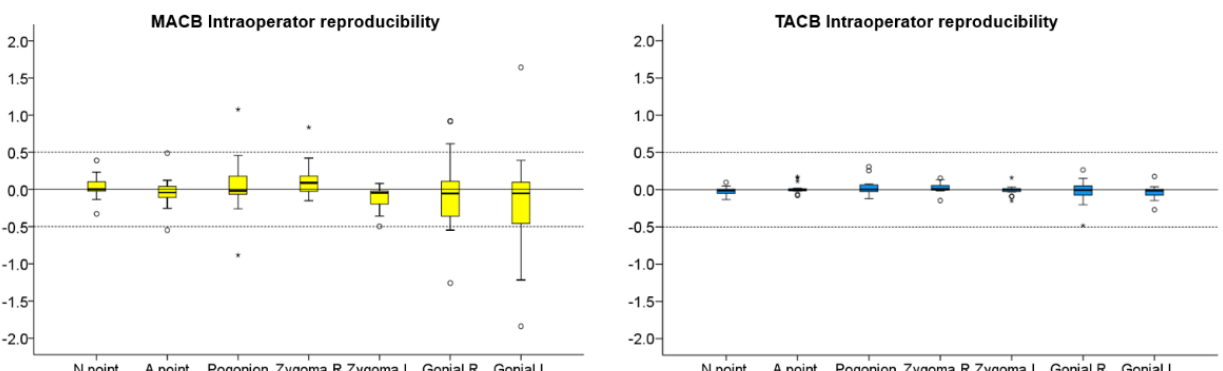
Figure 1. Box plots showing the intra-operator reproducibility of the MACB (Middle Anterior Cranial Base) and the TACB superimpositions (Total Anterior Cranial Base) for the detected T0–T1 changes in mm, for all measurement areas. The zero value, depicted by the continuous horizontal line, indicates perfect reproducibility, whereas any deviation from zero is considered an error. The dashed lines indicate 0.5 mm and −0.5 mm. In the boxes, the upper limit of the black line represents the maximum value, the lower limit the minimum value, the box the interquartile range, and the horizontal black line the median value. Outliers are shown as black dots or stars in more extreme cases.